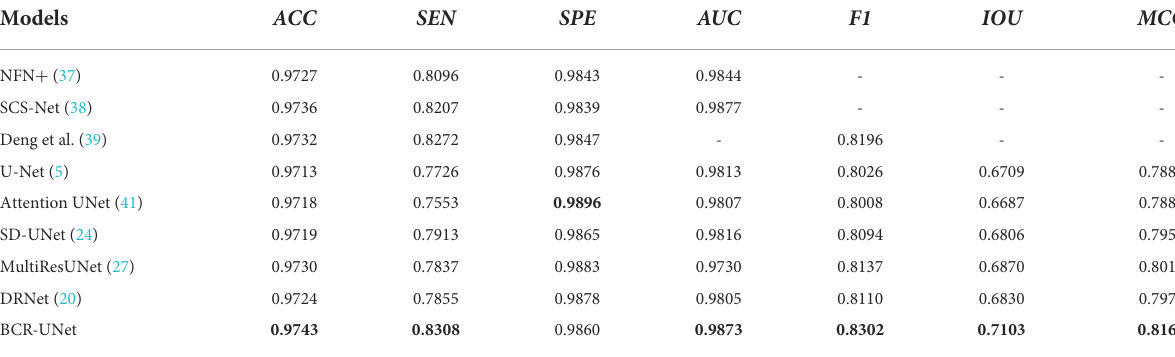
TABLE 7 Results of BCR-UNet and other methods on STARE dataset.